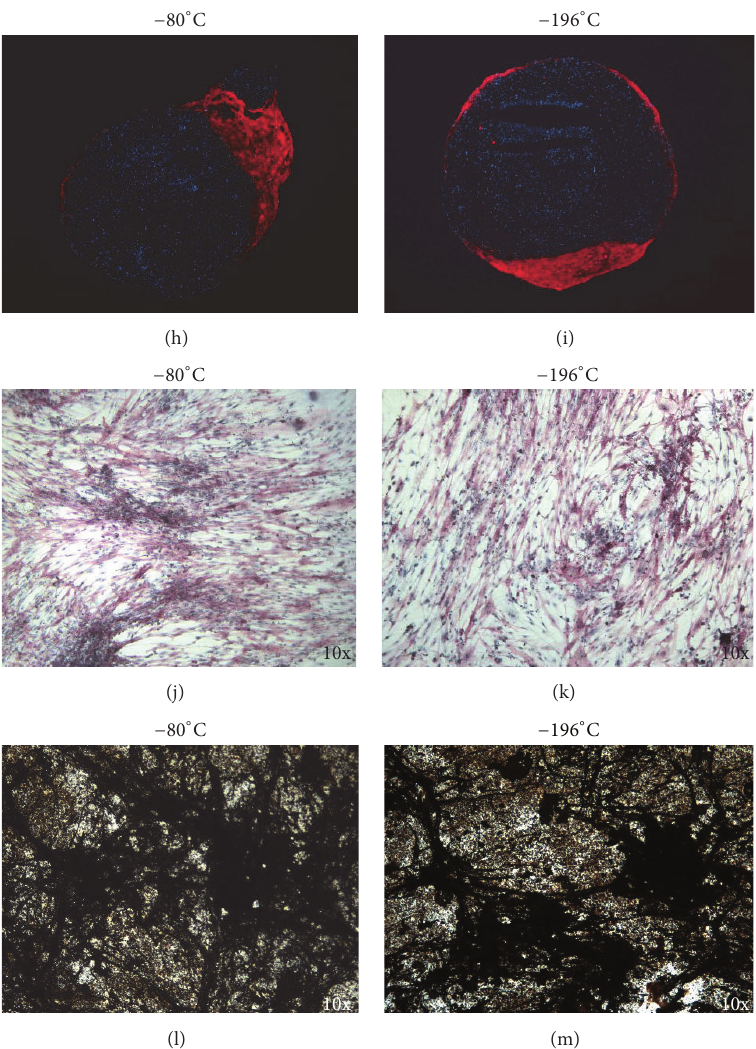
Figure 7: ATD-MSCs differentiating abilities in vitro were preserved at both temperatures of cryopreservation. After cell culture, ATD-MSCs assumed the typical fibroblast-like morphology (a) and expressed CD105, CD44, CD73, and CD271 (b–e). The immunophenotype of MSCs expressing CD105/CD44/CD73 and of the subpopulation CD105/CD44/CD73/CD271+ cells was comparable with both the temperatures of cryopreservation (f, g). Chondrocytes (h, i) and osteoblasts (j, k) formed from both adipose tissues cryopreserved at − 80 ∘ C and –196 ∘ C.